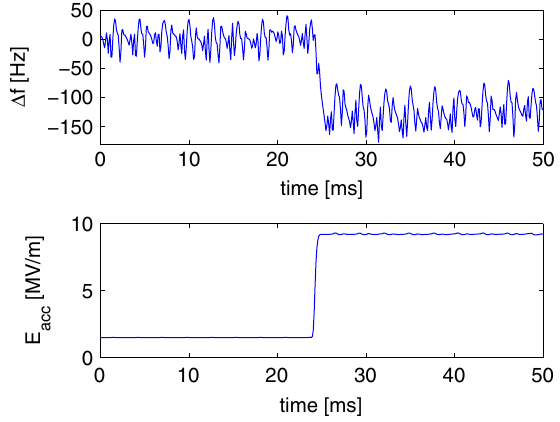
FIG. 18. Lorentz force detuning measurement of an ERL in- jector cavity.